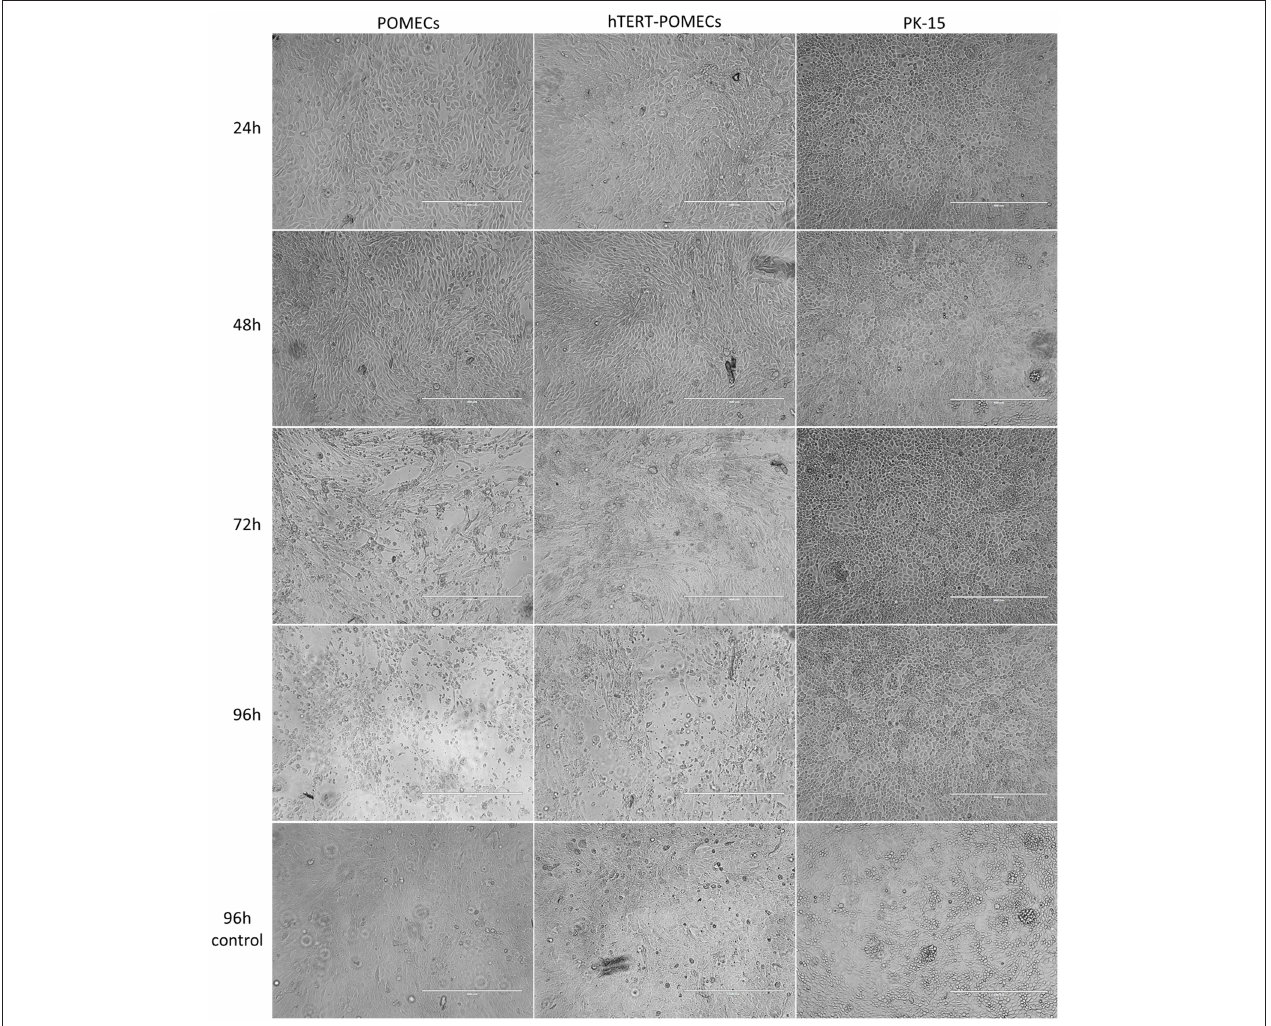
FIGURE 6 | Cytopathogenic effects in PCV2-infected hTERT-POMECs. Third passage POMECs, 70th passage hTERT-POMECs and PK-15 cells were infected with PCV2 at a MOI of 1. Cells were observed at 24, 48, 72, and 96 hpi. At 24 and 48 hpi, the PCV2-infected POMECs and hTERT-POMECs were elongated, and the intercellular space increased. At 72 and 96 hpi, visible cytopathogenic effects were observed in POMECs and hTERT-POMECs. No cytopathogenic effect was found in PK-15 cells. Uninfected POMECs, hTERT-POMECs and PK-15 cells served as controls ( × 100 magnification, scale bar is 400 µ